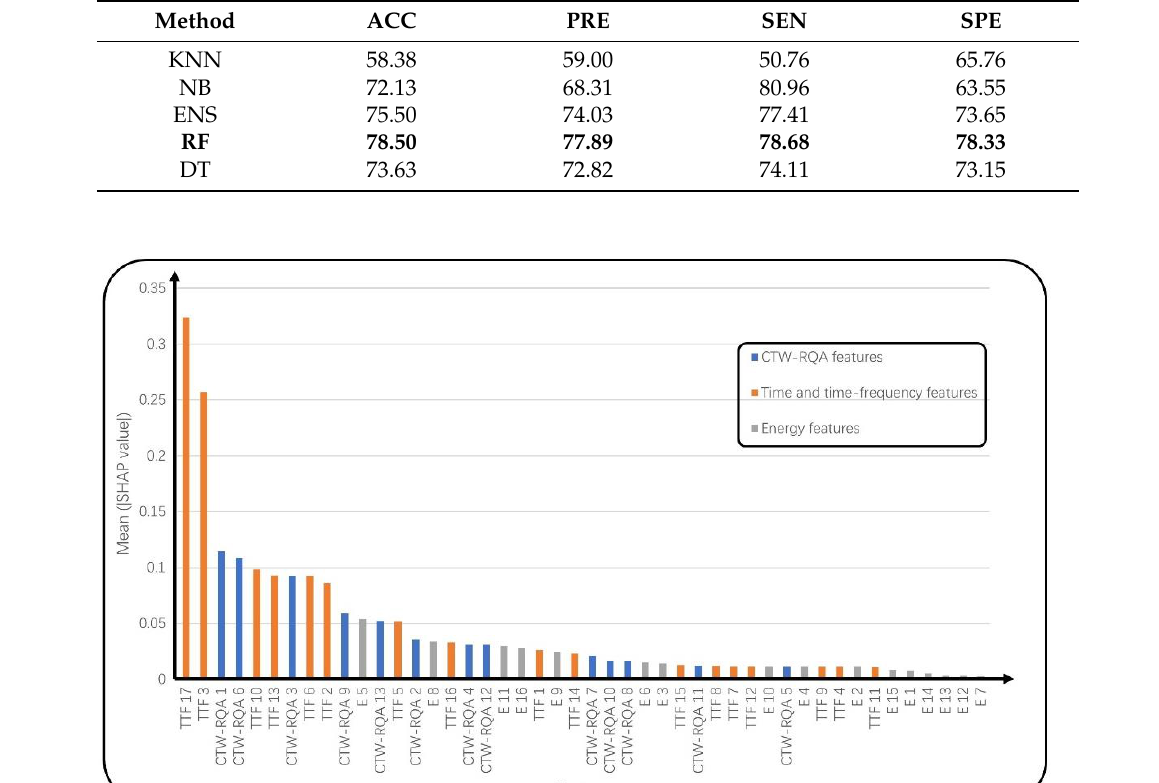
Table A3. AF detection performance based on CTW – RQA features ( n = 3).